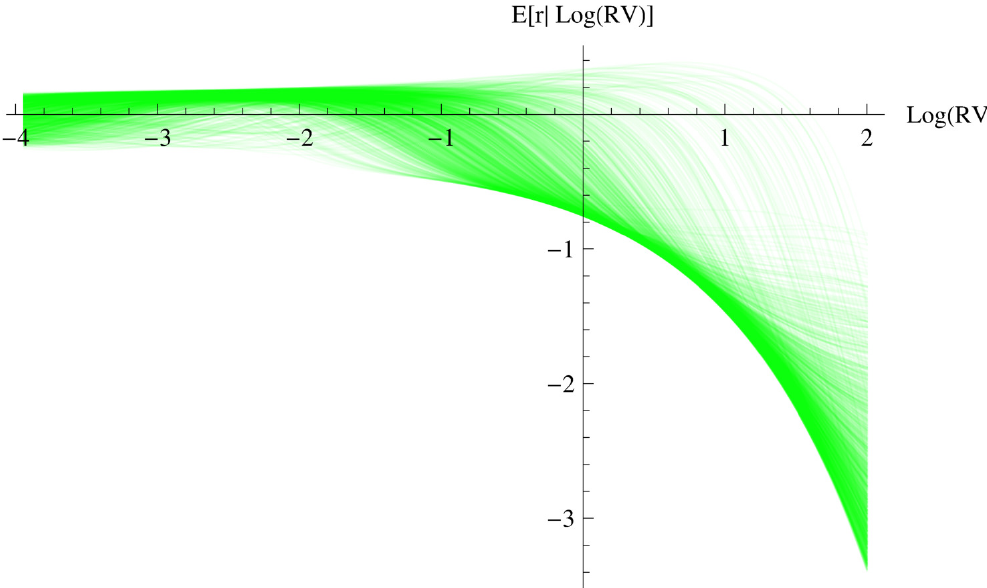
Figure 3. Expected return given log realized variance for each of the information sets I t − 1 , t = 2, . . . , T .